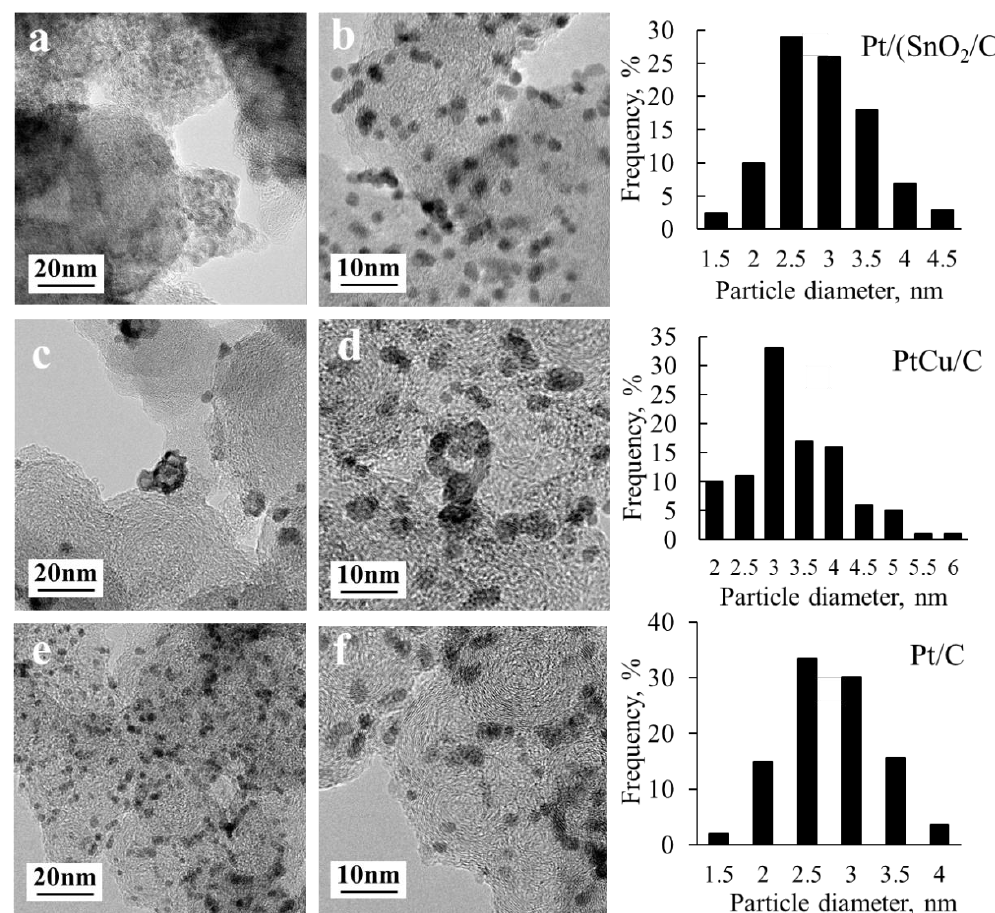
Figure 2. Photographs of transmission electron microscopy and histograms of the nanoparticles size distribution obtained on their basis, for samples ( a , b )—Pt/(SnO 2 /C); ( c , d )—PtCu/C; ( e , f )—Pt/C.